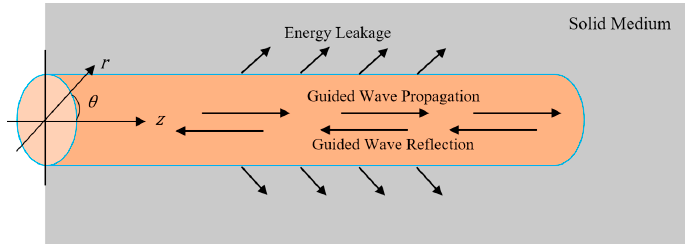
Figure 5. Geometry of a steel bar in solid medium.